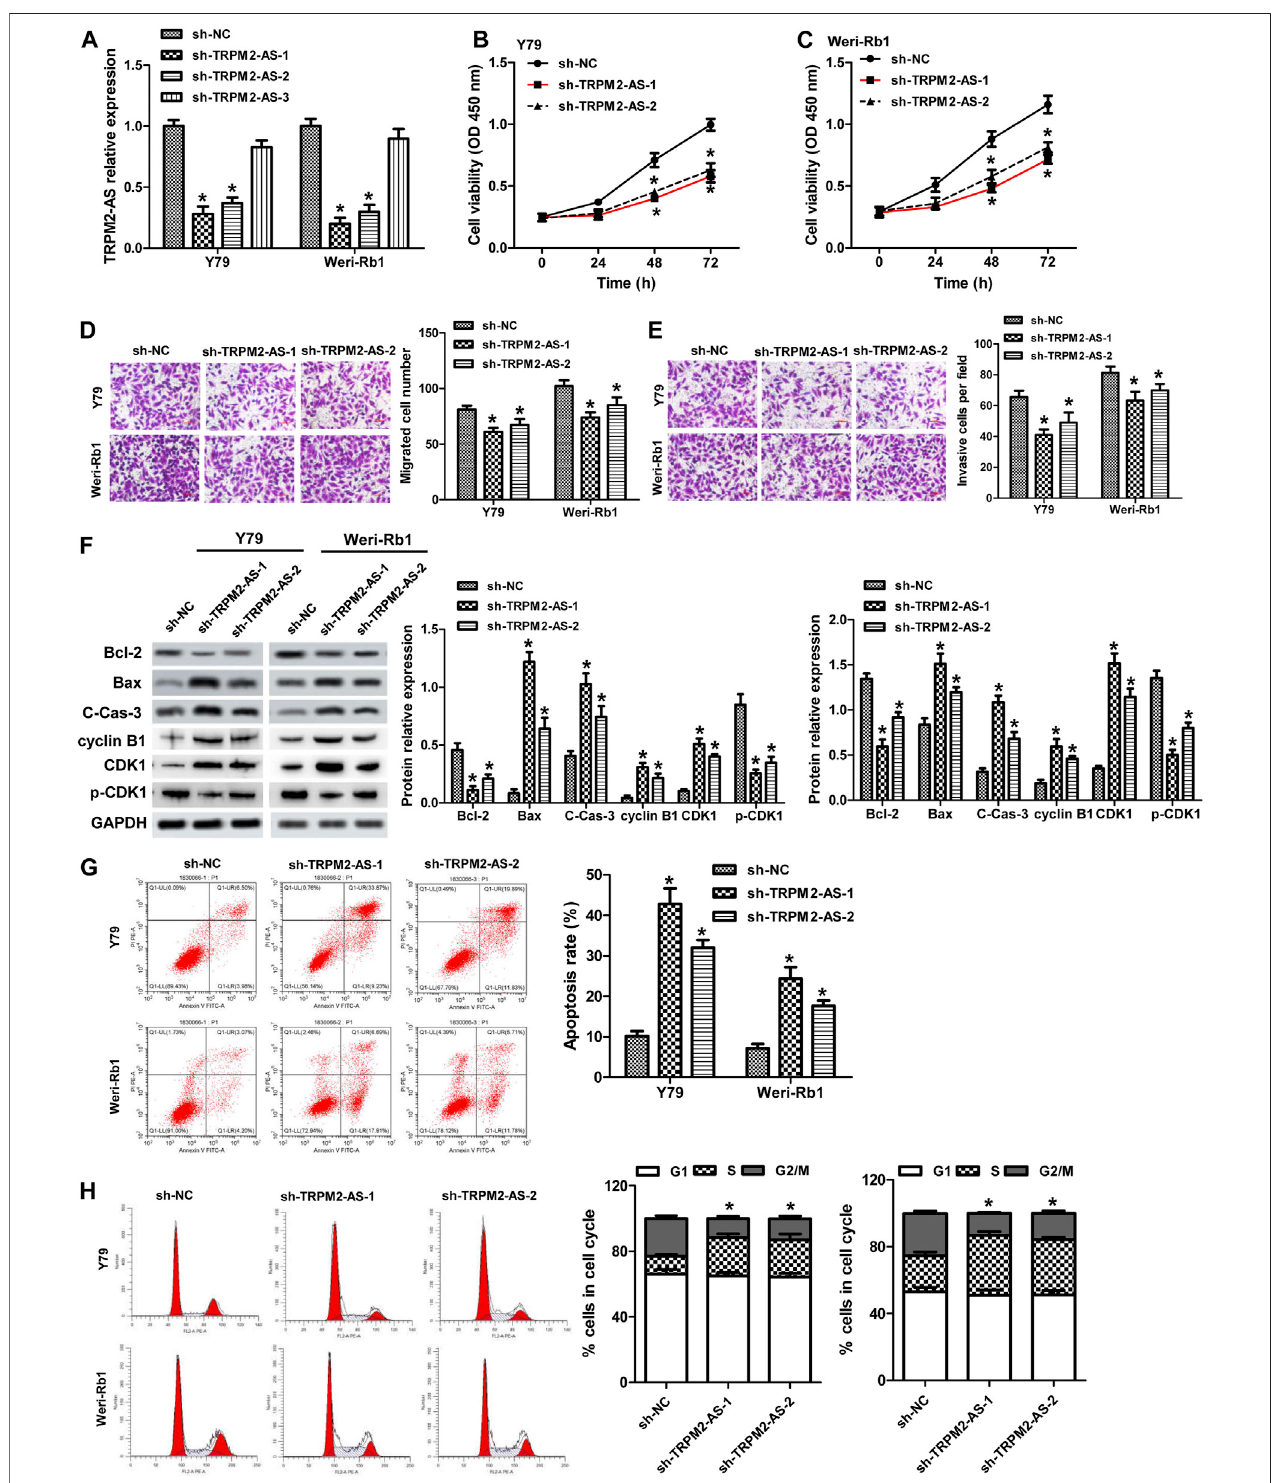
FIGURE 2 | Downregulation of TRPM2-AS decreases RB cell proliferation, migration, and invasion, promotes cell apoptosis, and attenuates G2/M phase arrest. (A) Y79andWeri-Rb1cellsweretransfectedwiththreeshRNAstargetingTRPM-AS-1,andtheknockdown ef fi ciencywasexaminedbyreal-timePCR.CCK-8assayfor the proliferation of Y79 (B) and Weri-Rb1 (C) cells. (D) Migration of both RB cells was inhibited by TRPM-AS-1 shRNA. (E) The invasion of RB cells was determined by transwell. (F) Protein levels of Bcl-2, Bax, cleaved caspase-3 (C-Cas-3), cyclin B1, CDK1, and p-CDK1 in Y79 and Weri-Rb1 cells were analyzed by western blot. (G) Flowcytometryassayfortheapoptosisofcells. (H) CellcycledistributionofY79andWeri-Rb1cellswasexaminedby fl owcytometry.* p < 0.05vs.thesh-NCgroup.